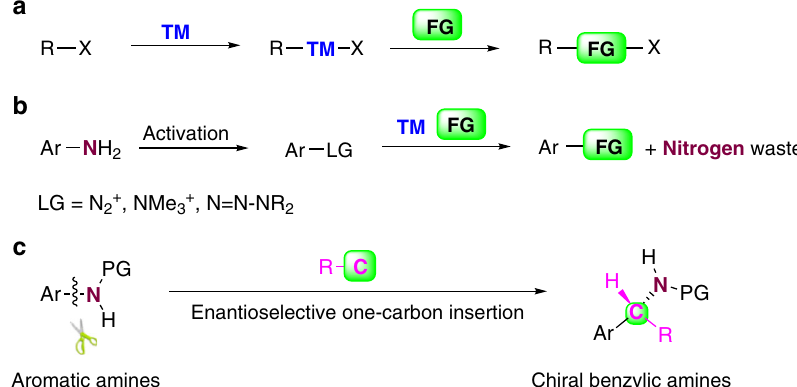
Fig. 1 Atoms insertion and transformation of aromatic N – C bonds. a Transition-metal-catalyzed atoms insertion. b Conventional transformation of aromatic nitrogen-carbon bonds. c One-carbon insertion into aromatic nitrogen-carbon bonds. TM transition metal, FG functional group, LG leaving group, PG protecting